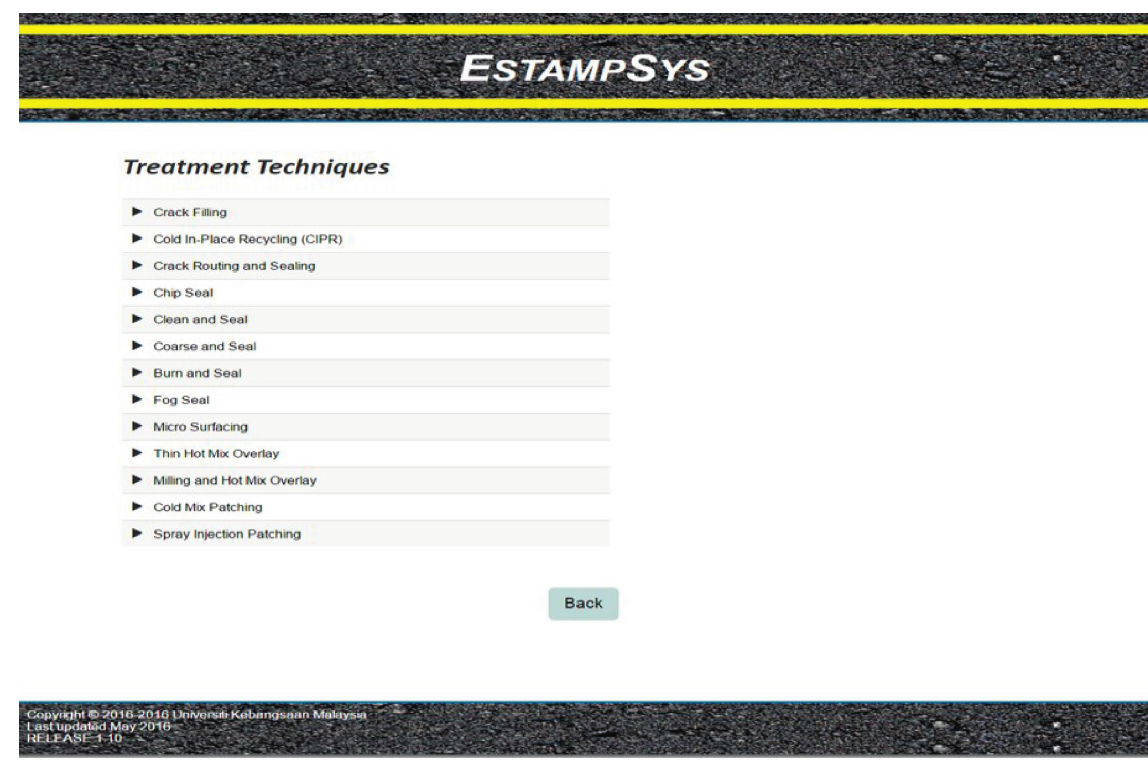
Figure 9: Screenshot of the treatment technique